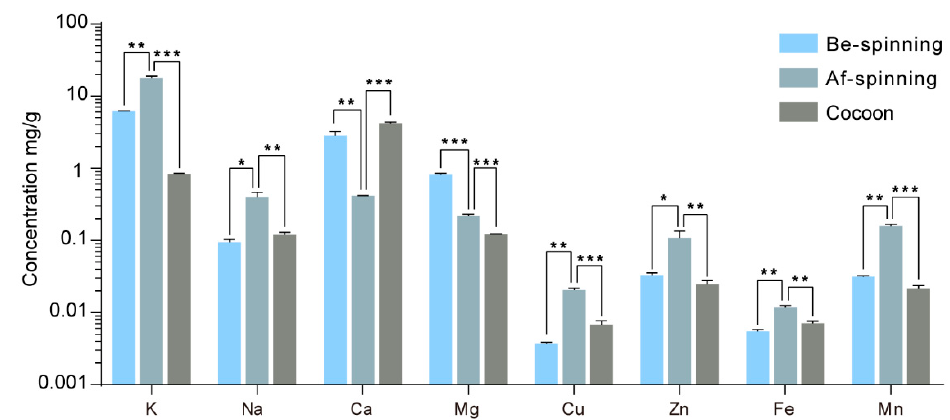
Figure 2. Content of metal elements in silk glands before and after spinning. (Be-spinning: before spinning, Af-spinning: after spinning. Error bars show SD, * p < 0.05, ** p < 0.01, *** p < 0.001 (One-way ANOVA). The y-axis data were processed by log 10).